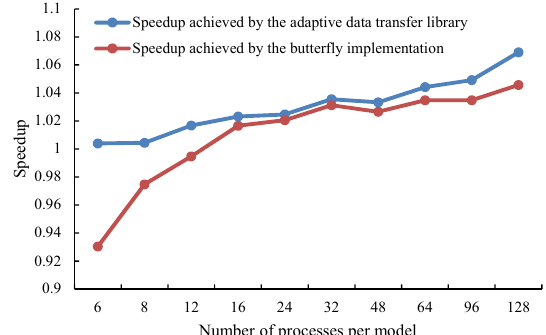
Figure 22. Performance improvement with respect to the whole model time for the coupled model GAMIL2–CLM3 achieved by the butterfly implementation and the adaptive data transfer library, using the P2P implementation as the